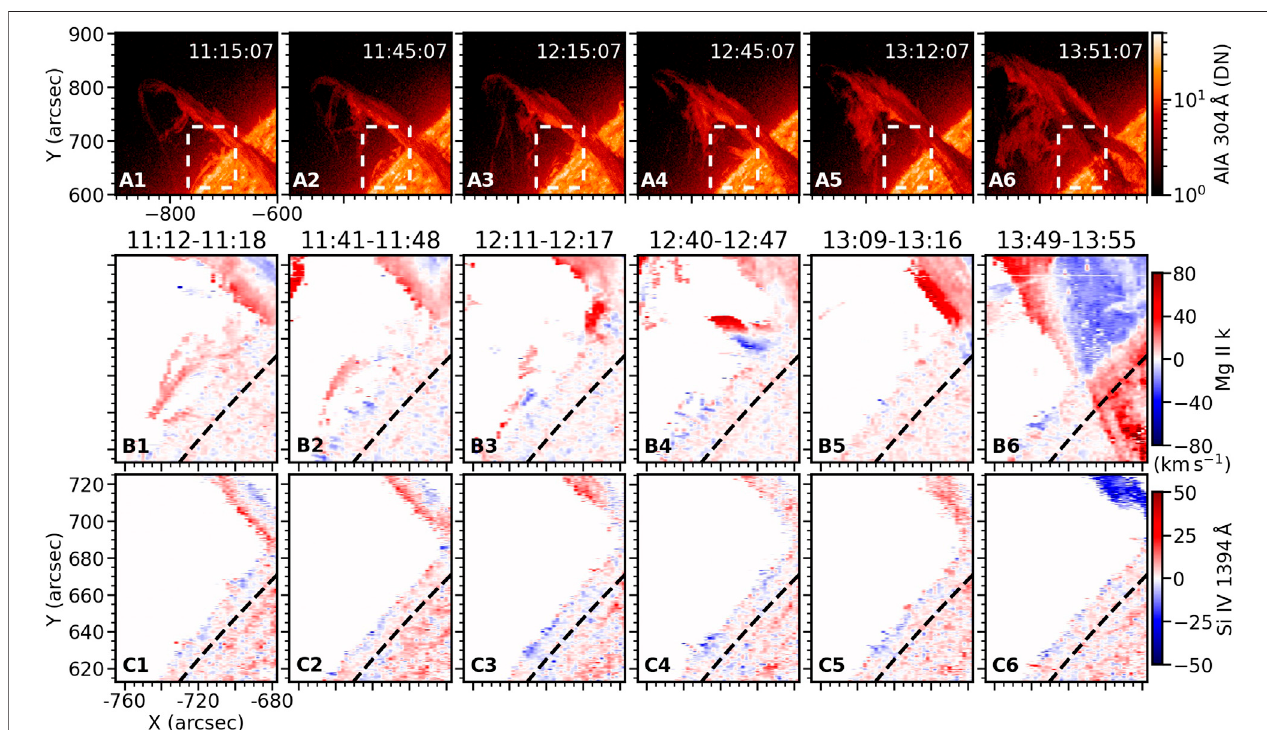
FIGURE 6 | Doppler images derived from the spectra of Mg II k ( fi rst row) and Si IV 1394 (cid:1) A (second row) using the COG method. First row: the AIA 304 (cid:1) A images. Secondandthirdrows:DopplerimagesfromtheMg II kandtheSi IV 1394 (cid:1) A lines,respectively.Each Dopplerimage iscomposed of44rasterstepsfromtheslitposition No.21 (left) totheslitpositionNo.64 (right) ,andtheobservationtimesofthetwoslitsaredenotedabove.Thedashedblacklinesrepresentthesolarlimb.Colorbarsare shown at the right for each